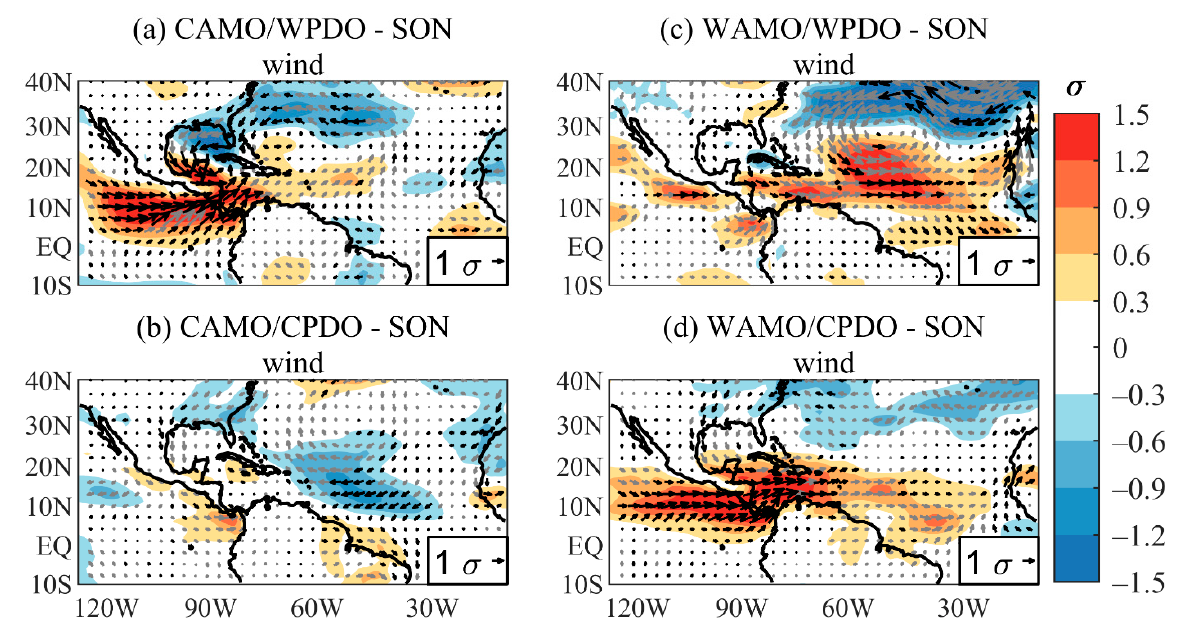
Figure 5. September–November standardized wind anomalies at 925hPa during intense CJ events of the: ( a ) CAMO/WPDO; ( b ) CAMO/CPDO; ( c ) WAMO/WPDO; and ( d ) WAMO/CPDO mean states. Shades interval is every 0.3 SDs. Shaded areas indicate significant zonal wind anomalies at a 95% confidence level based on the Student’s t-test. Vectors are in bold only in regions where are significant at 95% based on the Student test. The arrow at the bottom of each panel illustrates the base magnitude of the wind vector in σ .